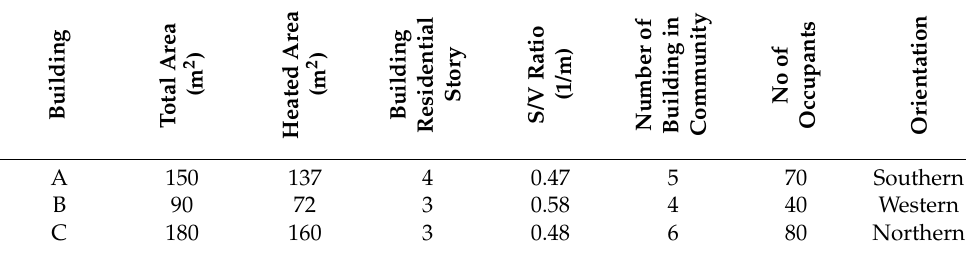
Table 4. Characteristics of the buildings modeled in